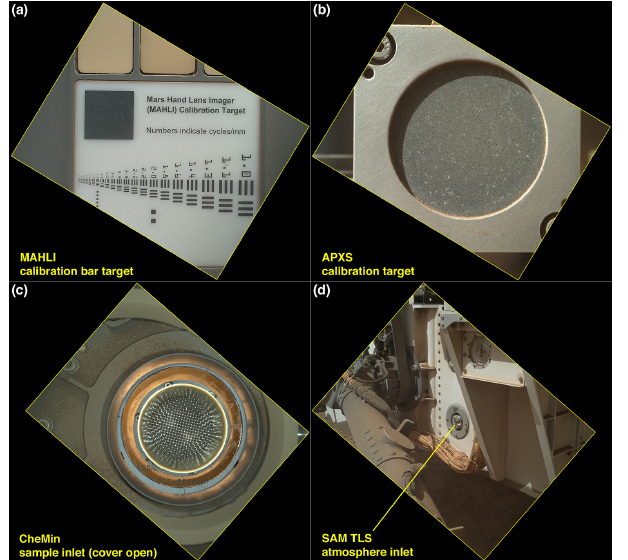
Figure 10. MAHLI images of science instrument hardware. Such images are acquired periodically, or as needed, to support instru- ment calibration, health, and safety. (a) Sol 989 (19 May 2015) im- age of a portion of the MAHLI calibration target (the full target includes the bar target seen here, as well as gray, color (RGB) and UV fluorescent swatches, stair steps, and a US cent; Edgett et al., 2012); these images are acquired on a ∼ 180-sol cadence to monitor camera performance. Illuminated by sunlight from the top, this is MAHLI image 0989MH0004980050304442C00. (b) MAHLI im- age 0591MH0003730010203137C00, illuminated by sunlight from the upper left on sol 591 (5 April 2014), of Curiosity’s Alpha Parti- cle X-ray Spectrometer (APXS) calibration target; these images are also obtained on a ∼ 180-sol cadence to record dust cover (Camp- bell et al., 2014). (c) MAHLI view of the CheMin sample inlet (Blake et al., 2012) focused on the inlet funnel and on the 3.5cm diameter millimeter mesh overlying the funnel; acquired after de- livery of the sample to the CheMin instrument. Imaging of the in- let mesh and funnel is used to detect remnant material in the in- let after delivery and verifies removal of such material before the next sample delivery. Illuminated by all four of MAHLI’s white light LEDs at night, this is sol 895 (12 February 2015) image 0895MH0002280000302809C00. (d) Curiosity’s Sample Analysis at Mars (SAM) Tunable Laser Spectrometer (TLS) atmospheric gas inlet on the starboard side of the rover chassis. Early in the mis- sion, MAHLI supported SAM operations by looking for evidence of disrupted sample delivery in images of both closed SAM in- let covers. Being the only camera on the rover capable of view- ing it, MAHLI was used on sol 544 (16 February 2014) to seek evidence for a suspected obstruction in the SAM TLS inlet. Il- luminated by sunlight from the upper left, this is MAHLI image 0544MH0003450010201448C00. Its acquisition was challenging for robotic arm positioning and thus planning for it spanned several months and included testing the operation on the full-scale testbed rover at the California Institute of Technology’s Jet Propulsion Lab- oratory.